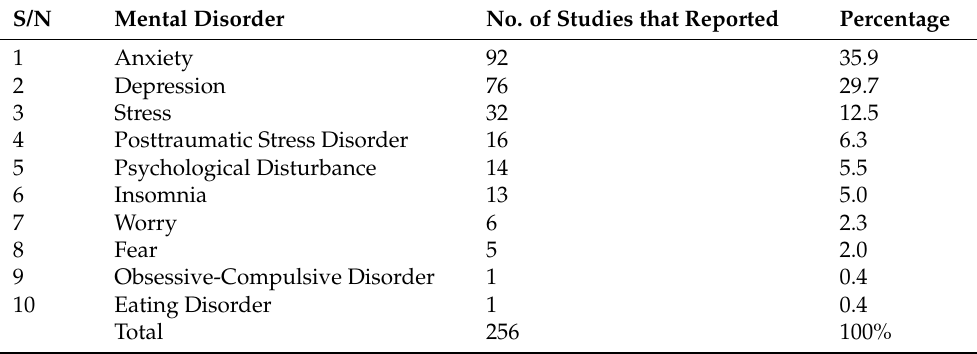
Table 2. Summary of Mental Disorders and Number of Studies